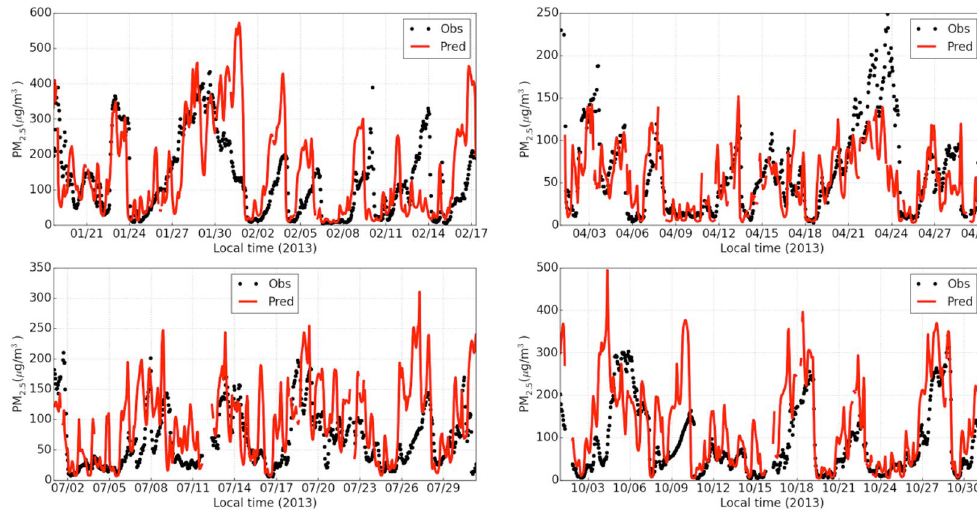
Figure 6. Time-series comparisons of the observed (Obs) and predicted (Pred) hourly mean PM 2.5 concentrations in Beijing for January-February, April, July, and October